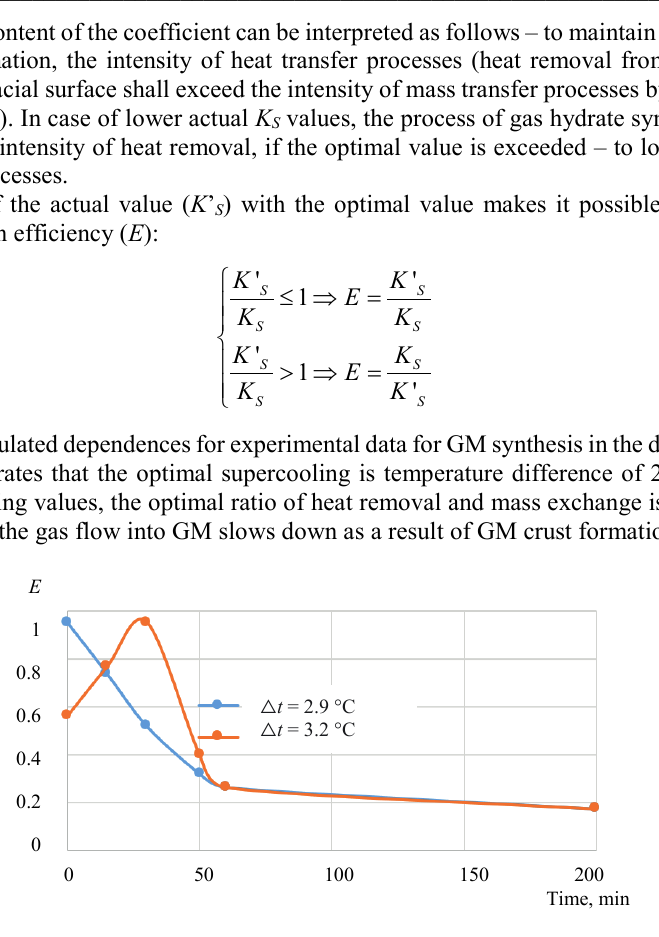
Fig. 8. The efficiency of the hydrate formation process in diffusion mode ( E ) depending on gas supercooling (Δ t ) and time according to experimental study results. Fig. 9 shows graphs of GM synthesis process intensity by the value of optimization coefficient K ’ S . As it is shown in the graph, the movement of values of graph functions to the right of the optimal zone I corresponds to a decrease in the rate of GM synthesis and gas content in the gas hydrate